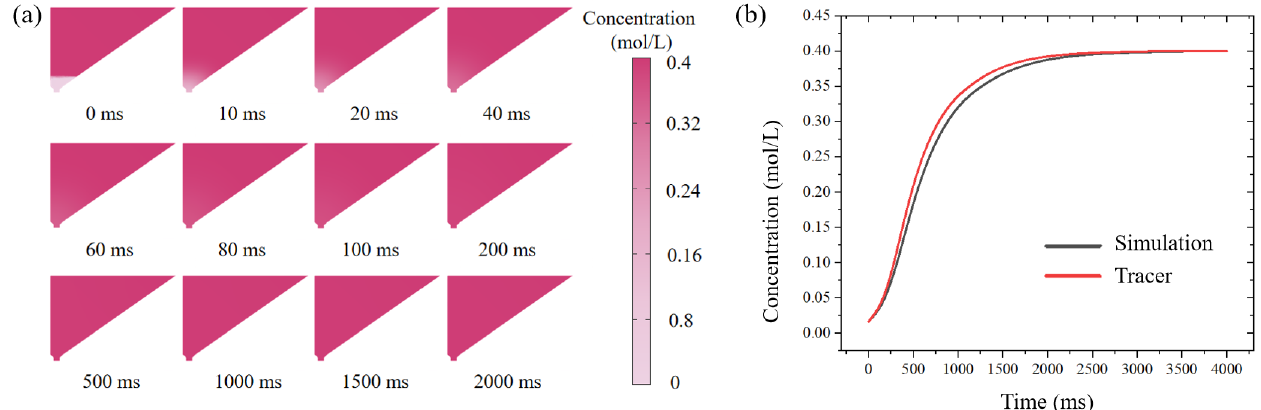
Figure 6. Theoretical and experimental VS concentration around the oocyte with respect to time. ( a ) Simulated time-dependent sucrose concentration in the oocyte chamber under diffusion condition (initial concentration upper: 0.4 mol/L; bottom: 0 mol/L). ( b ) Gray: the numerically predicted sucrose concentration in the oocyte chamber over time; Red: the experimentally measured intensity of the fluorescent tracer in the oocyte